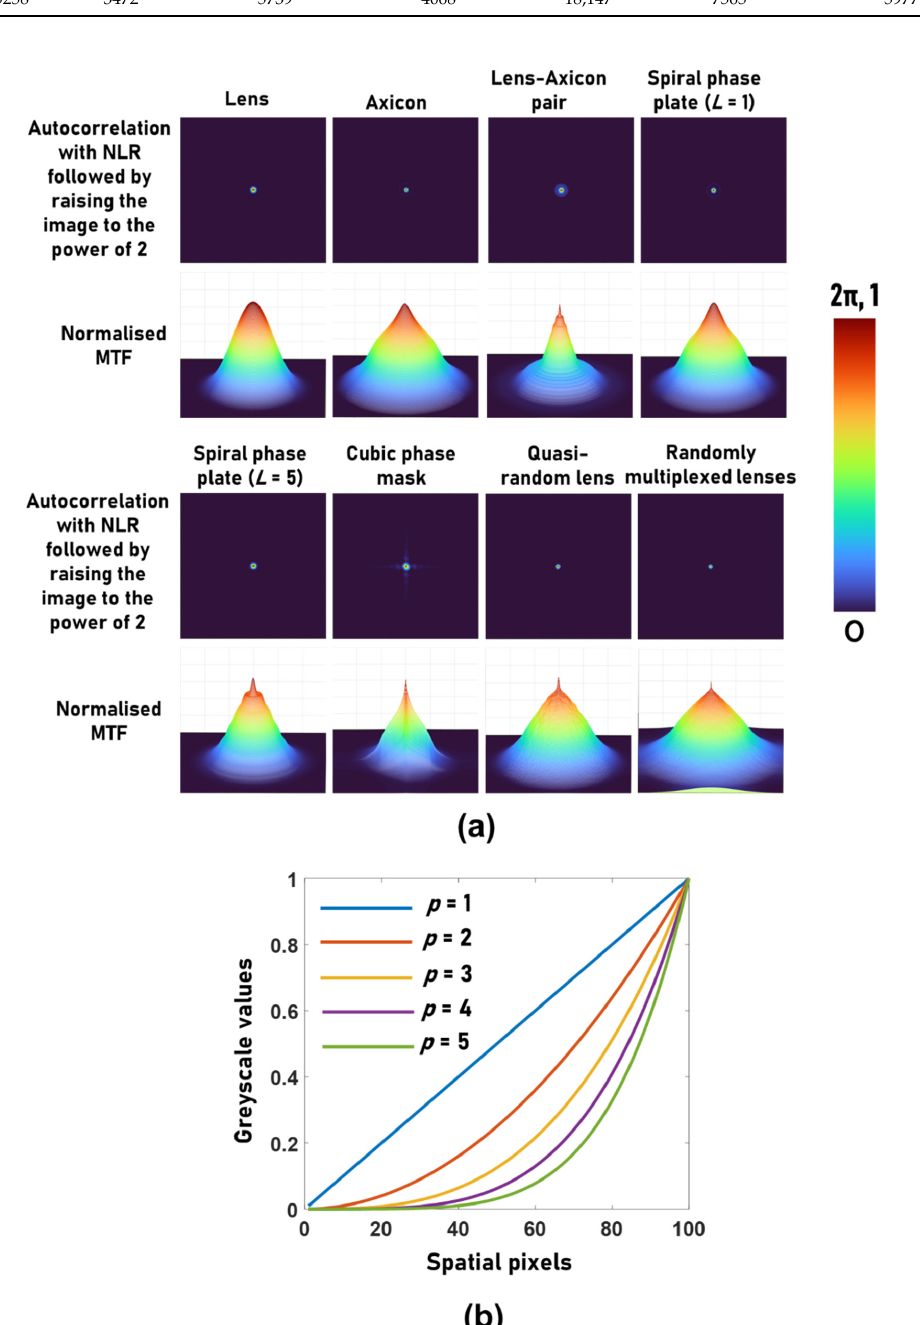
Figure 3. ( a ) Autocorrelation with NLR followed by raising the image to the power of p = 2 and their respective MTF profiles. ( b ) The influence of p on a grayscale slope. A test object, “MDPI JOURNAL OF IMAGING,” with varying font sizes and different gray levels, was used. Two objects: grating with varying periods and a wheel-like object, were added to the input picture. The intensity distribution simulated for different cases